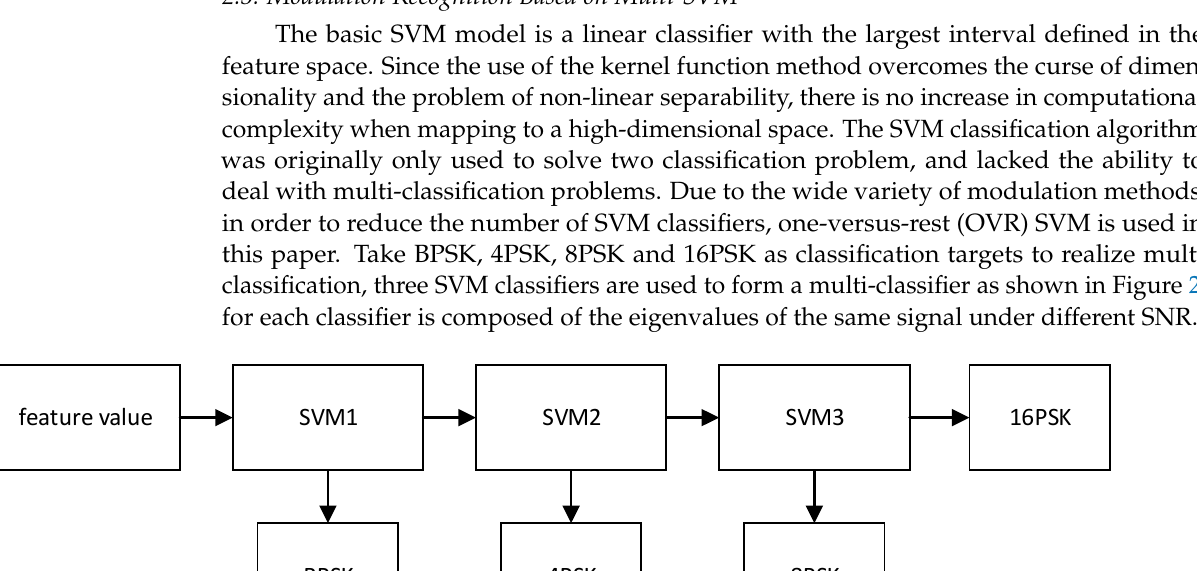
Figure 3. Signal Constellation Chart (SNR = 6 dB) ( a ) BPSK; ( b ) QPSK;( c ) 8PSK; ( d ) 16QAM; ( e ) 32QAM.